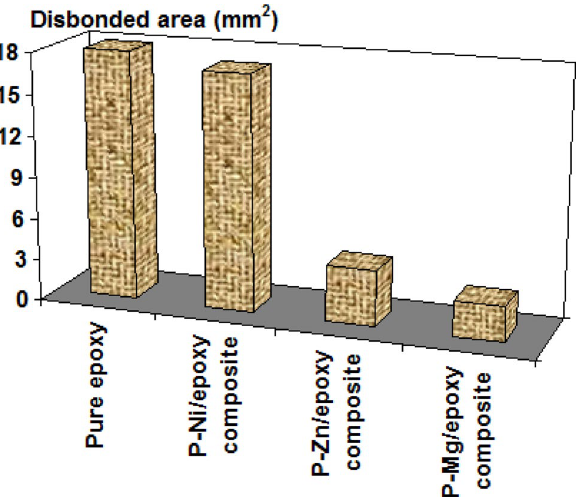
Figure 4. cathodic de-lamination data for neat epoxy, P–Ni/epoxy, P–Zn/epoxy and P–Mg/epoxy nanocomposites in 3.5% NaCl solution at 303 K.